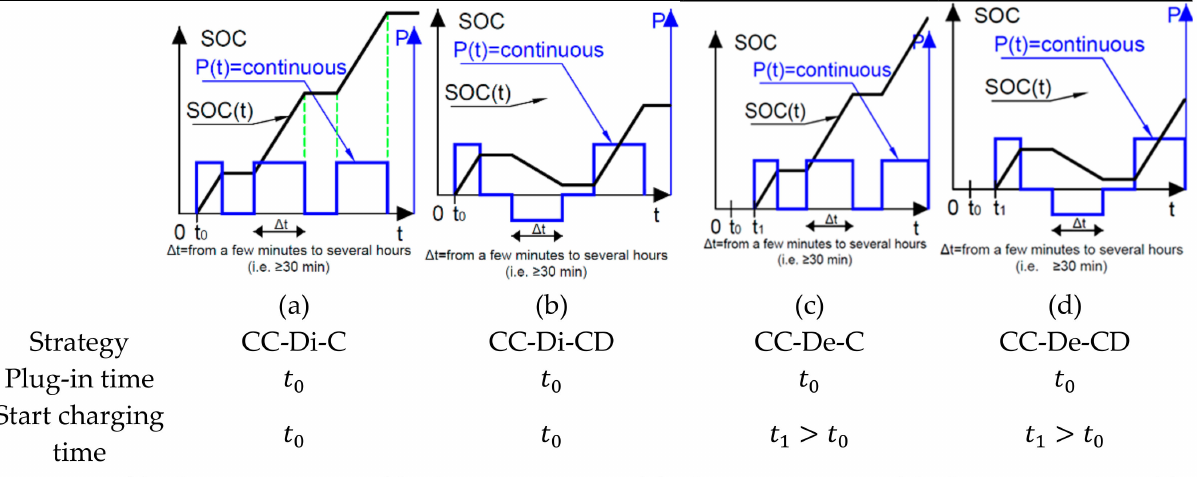
Figure 3. Illustration SOC and Discharge Power for Continuous Coordinated